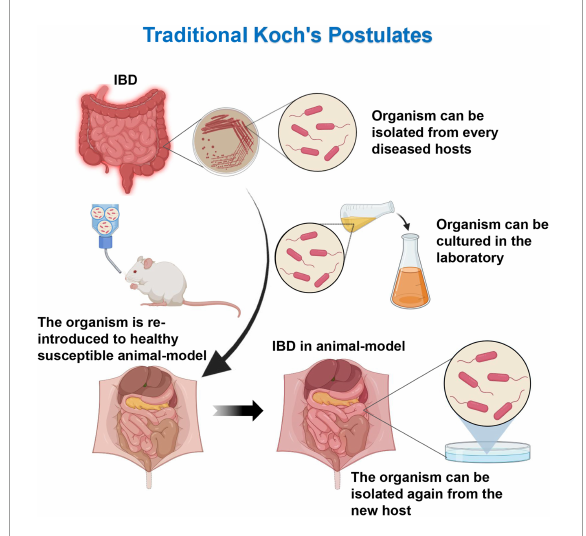
FIGURE1 Traditional Koch’s postulates. The microorganism must be present in every case of the disease and can be isolated from the diseased host. After cultured in the laboratory, the microorganism can cause the same disease when introduced into a new